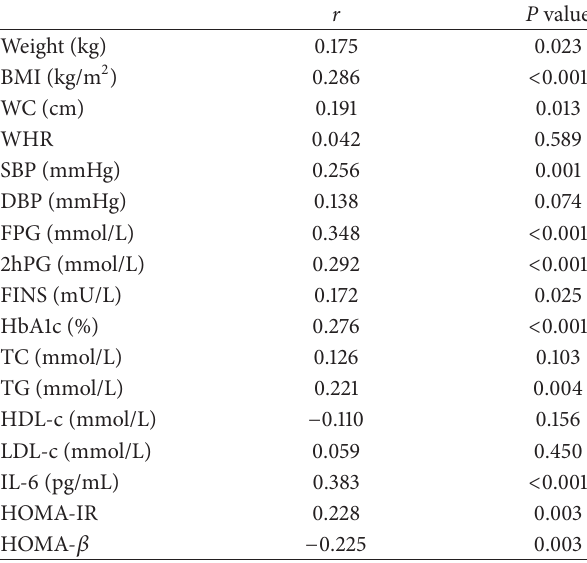
Table 2: Univariate associations between plasma PGRN levels and metabolic parameters.